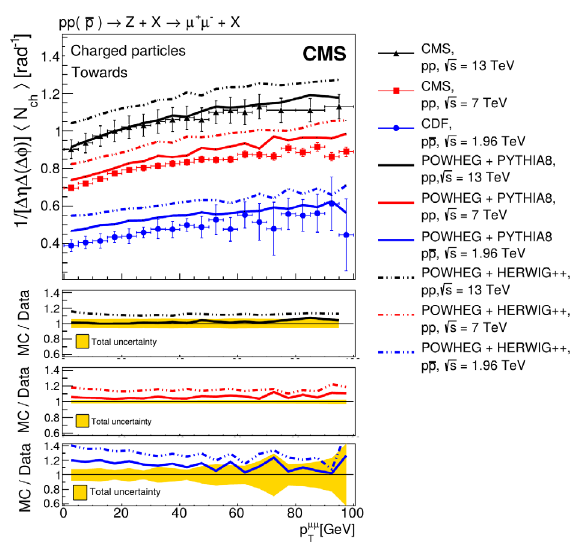
Figure 7. The ratio between proton-lead by lead-proton rates of very forward jets measured in CASTOR as function of the observed jet energy, see Ref. [10].